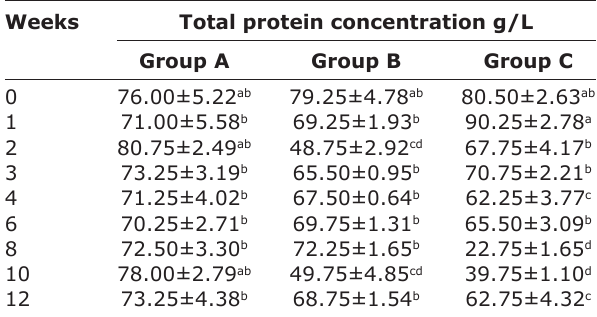
Table-10: Basophil count in female goat’s postinoculation with C. pseudotuberculosis and MA.